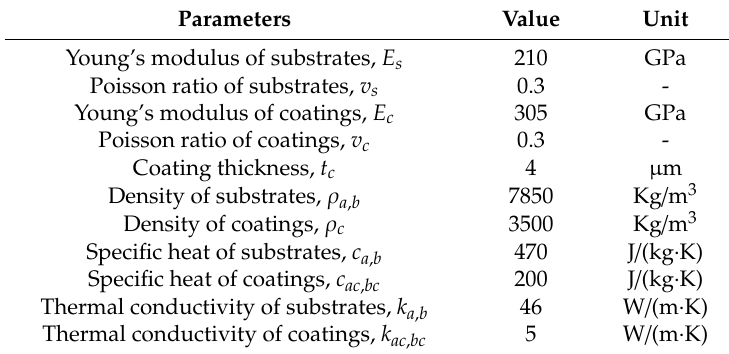
Table 3. The mechanical / thermal properties of substrate material and the coating layer.